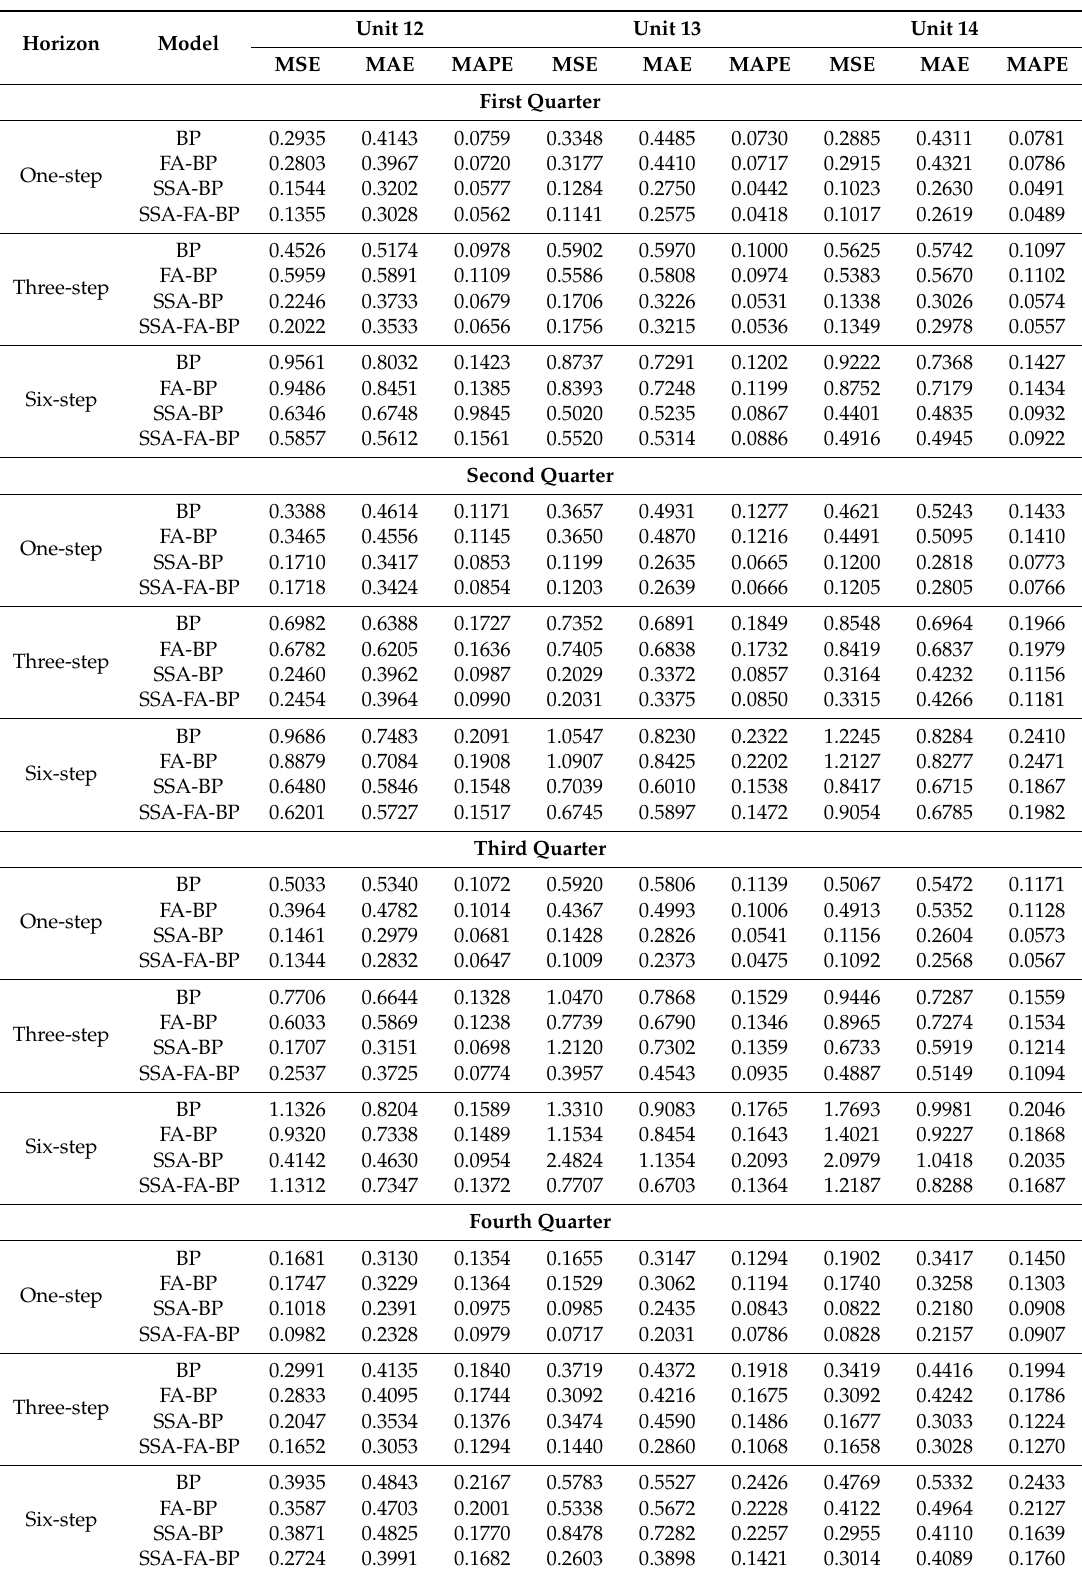
Table 4. The quarterly forecasting results of the combined model and the results of the other models involving the data of three Units (10